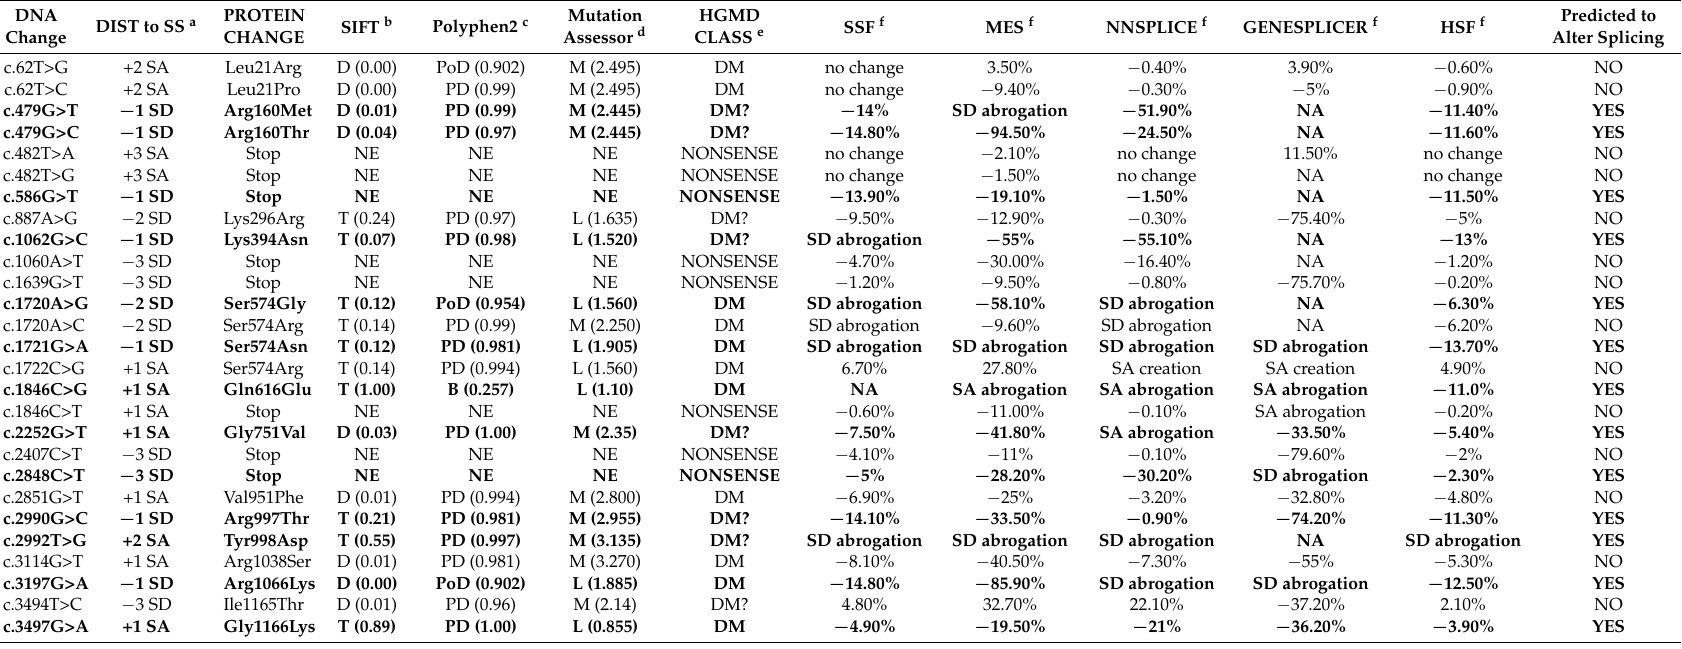
Table 4. In silico analysis of nucleotide substitutions in exon positions − 3, − 2, − 1 and +1, +2,